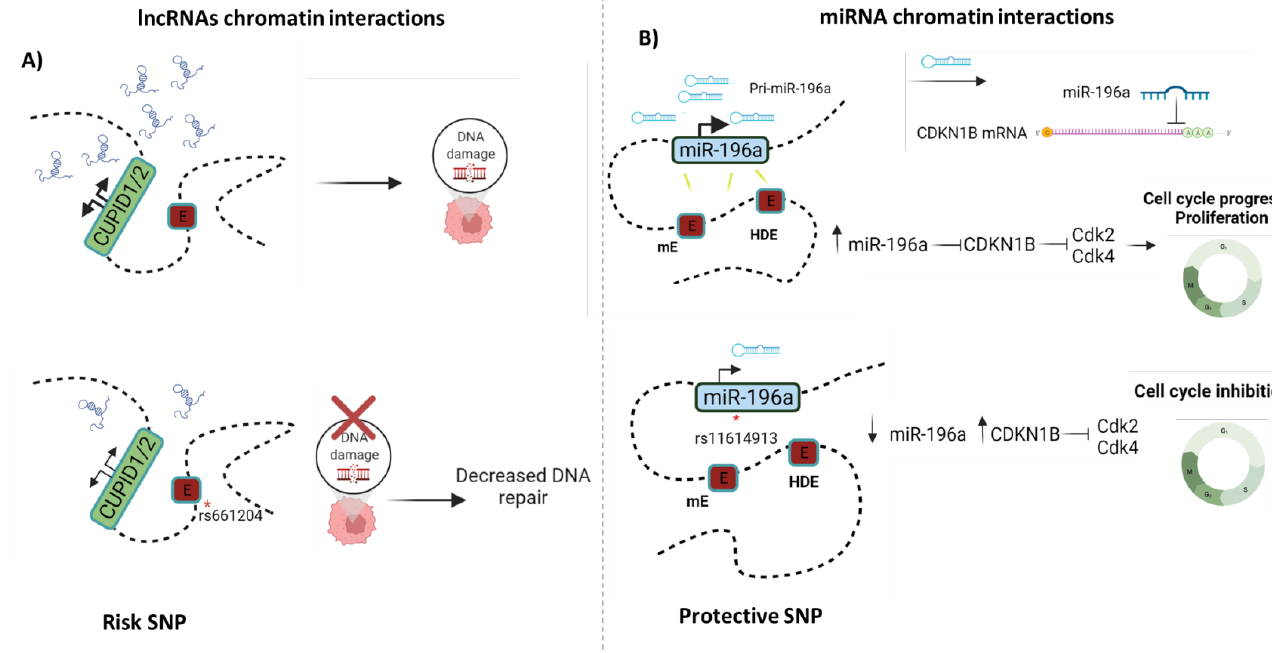
Figure 4. ncRNA-chromatin interactions: ( A ) Enhancer-lncRNA interactions. CUPID1 and CUPID2 are two lncRNAs that are transcribed from a bi-directional promoter and regulated by the enhancer PRE1. When DNA is damaged, CUPID1/CUPID2 favor double-strand break repair. However, reduced chromatin looping between the enhancer and the bi-directional promoters of CUPID1 and CUPID2 has been reported as being mechanistically responsible for the breast cancer risk- associated SNPs rs661204 [133]; ( B ) Enhancer-miRNA interactions. In breast cancer cells, increased miR-196a expression is associated with HOTAIR-enhancer and miR-196a-enhancer. Furthermore, overexpression of this miRNA is linked to proliferation through suppressing CDKN1B. A protective SNP rs11614913 within the miR-196a gene has been linked to a lower risk of breast cancer and decreased miR-196a expression, suggesting a weaker interaction between enhancers with the miR- 196a promoter